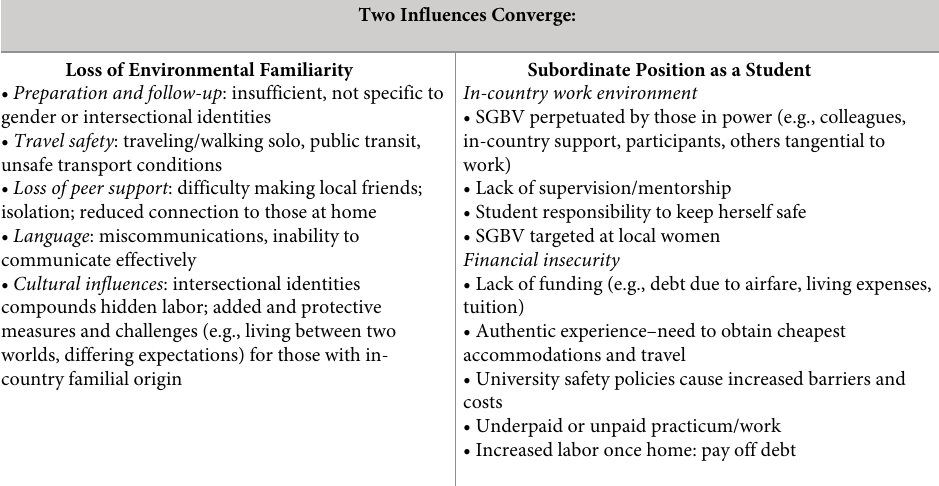
Table 1. Creation of hidden labor in global public health fieldwork. Two Influences